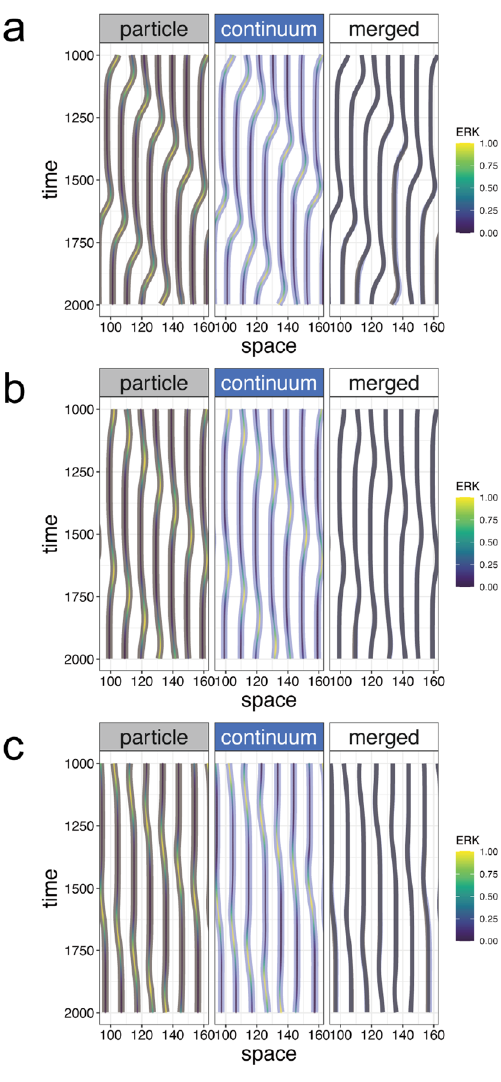
Figure 4. Comparison between the particle-based and continuum models in 1D simulation Comparisons between the migration trajectories simulated by two models with the same parameter values. In the left and center panels, the shaded gray and blue lines indicate trajectories simulated by the particle-based and continuum models, respectively, and the color of the inner lines indicates ERK activity. In the right panels, the shaded gray and blue lines were merged for comparison. Parameters used in ( a ), ( b ), and ( c ) are the same as Fig. 2b–d,